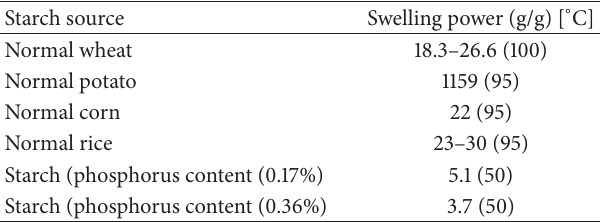
Table 1: The values of swelling power